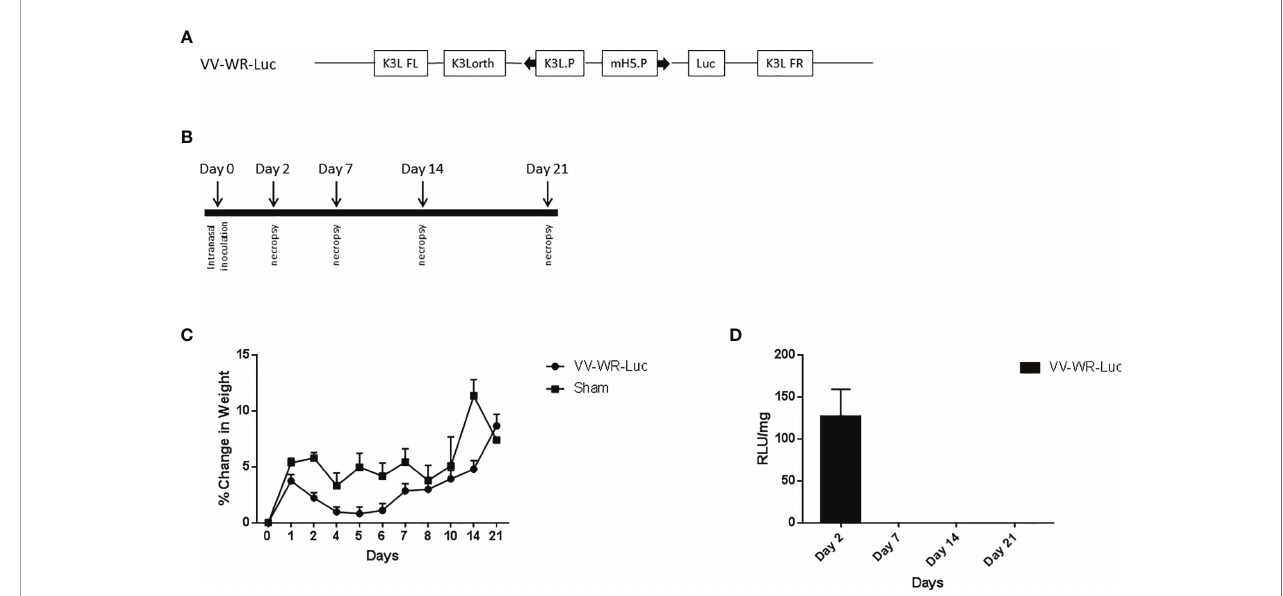
FIGURE 1 | Vaccinia vectored construct and intranasal inoculation regimen for virulence assessment. (A) Schematic representation of the WR vaccinia virus construct VV-WR-Luc expressing the fi re fl y luciferase gene. The luciferase protein transgene is under the control of the mH5 promoter, mH5.P. This sequence is fl anked by the K3L ortholog regions. (B) Schematic diagram of the intranasal inoculation and necropsy timeline. (C, D) Intranasal administration of VV-WR-Luc results in minor transient weight loss and localized transgene expression. Balb/c mice were intranasally administered 10 6 PFU of the VV-WR-Luc construct or sham and daily bodyweights were measured. Mice were necropsied at day 2, day 7, day, 14, and day 21 with n = 5 mice per timepoint per group. (C) % change in body weight compared to day 0 and (D) Transgene expression in the lungs expressed as Relative Luminescence Units (RLU)/mg of tissue is shown. Brain and trachea not